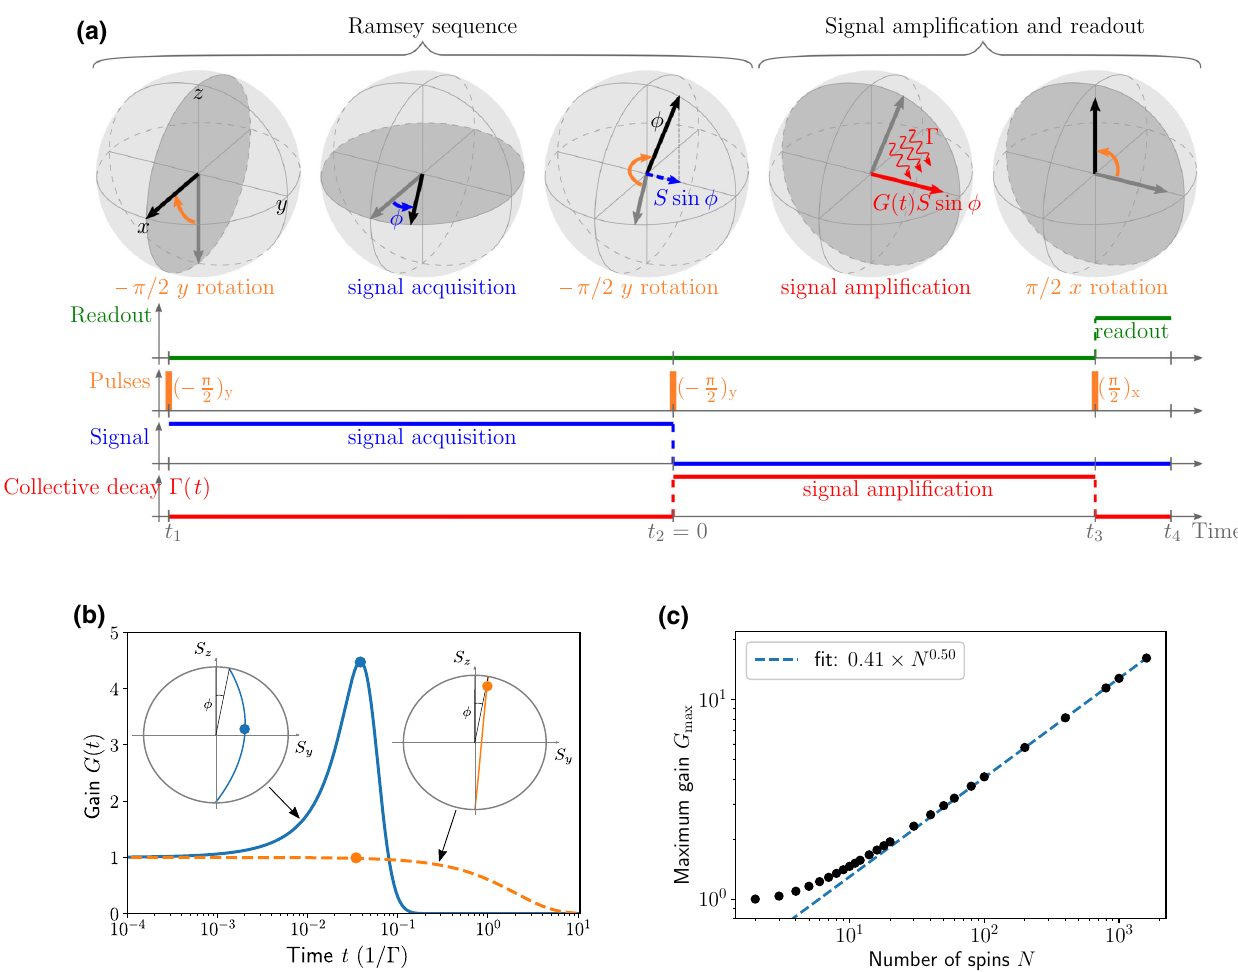
FIG. 1. (a) A schematic showing the superradiant-amplification-enhanced Ramsey measurement protocol: the time evolution of the collective spin vector on the Bloch sphere (top row) and the corresponding control operations (bottom row). A standard Ramsey ˆ sequence encodes a small phase shift φ of interest in the S y spin component. The final state of the Ramsey sequence is chosen to be close to the north pole of the collective Bloch sphere to provide energy for the subsequent amplification step. Collective decay [i.e., the second term in Eq. (3)] leads to passive transient amplification of the signal by a time-dependent gain factor G ( t ) . The decay is ˆ interrupted at the time of maximum gain and a final π/ 2 rotation maps the amplified signal onto the S z component for readout. (b) The ˆ time-dependent gain G ( t ) [defined in Eq. (10)] for collective decay (solid blue curve, numerically exact solution of d ˆ ρ/ dt = (cid:5) D [ S − ] ˆ ρ ) (cid:2) D [ ˆ σ ( j ) N ˆ ρ ). Only collective decay leads to transient amplification, versus single-spin decay (dashed orange curve, d ˆ ρ/ dt = (cid:5) − ] j = 1 i.e., G ( t ) > 1. We use N = 120 spins and an initial coherent spin state in the y - z plane as shown in the third Bloch sphere in (a) with φ = 10 − 5 . The insets show sketches of the corresponding trajectories of the spin vector (the initial angle φ is exaggerated for readability). (c) The scaling of the maximum gain G max with the number N of spins. The black circles are obtained by full numerical solution of the master Eq. (3) for γ rel /(cid:5) = 0. The dashed blue line indicates a fit for large N